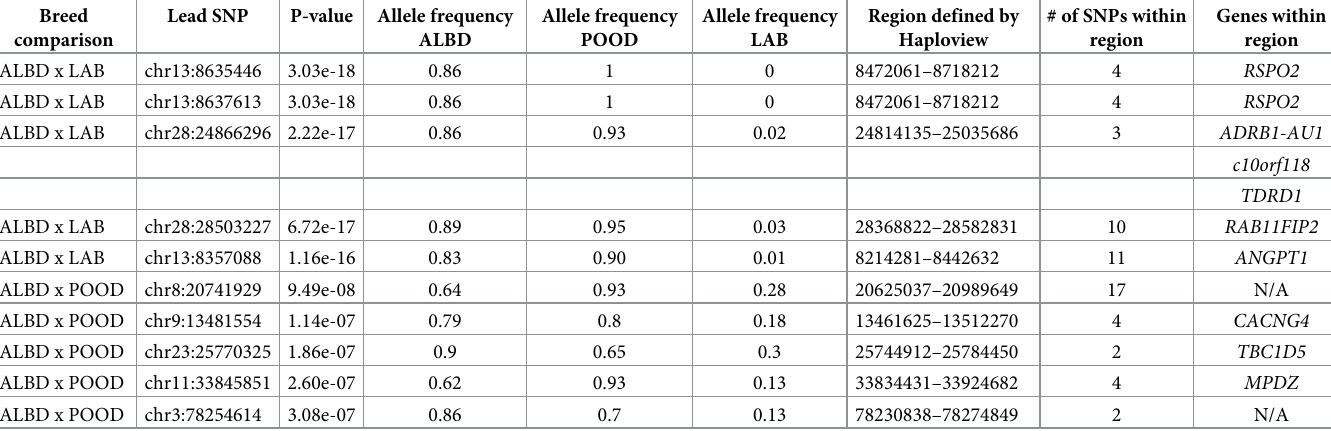
Table 2. Top five SNPs with significant allele frequency differences between ALBD and LAB or POODs and most proximal genes. Breed Lead comparison